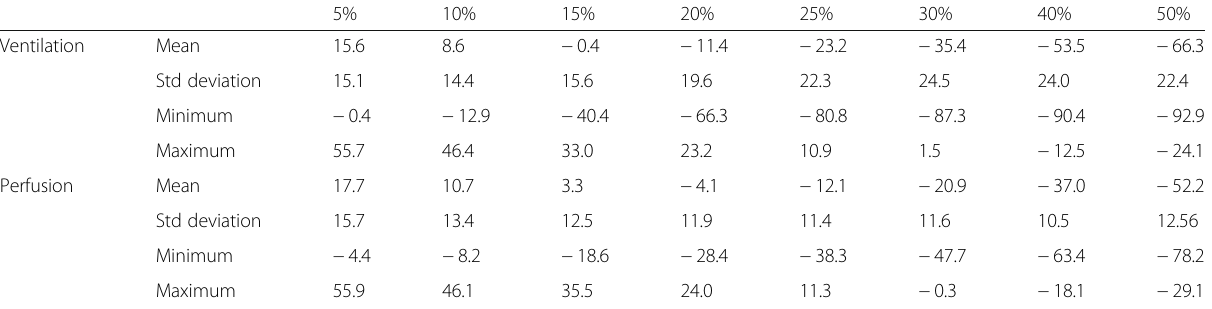
Table 1 Mean, standard deviation, minimum and maximum volume difference between the automatic methods, and the reference standard 5%